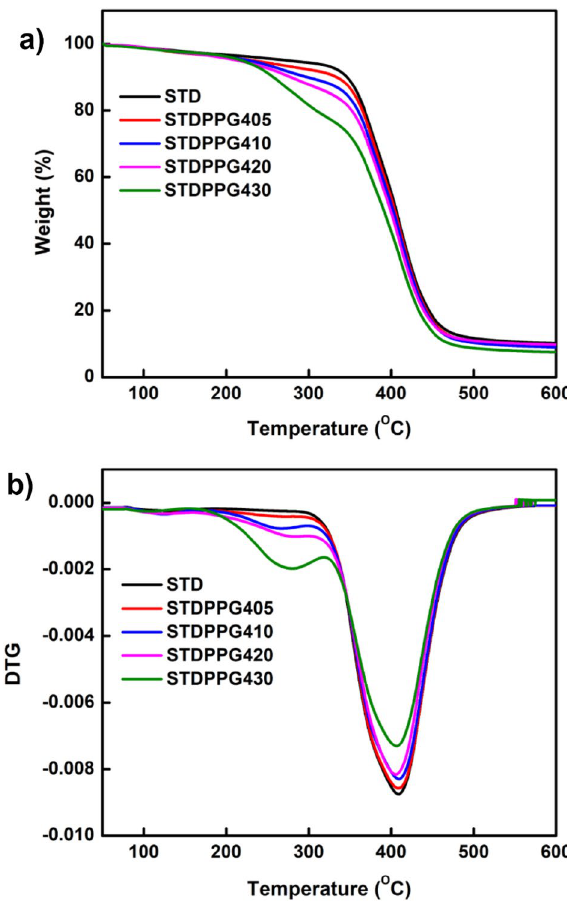
Figure 2. ( a ) Thermogravimetric analysis (TGA) curves and ( b ) derivative thermogravimetric analysis (DTG) curves of UV-curable acrylate-based resin (STD) and formulated resins with